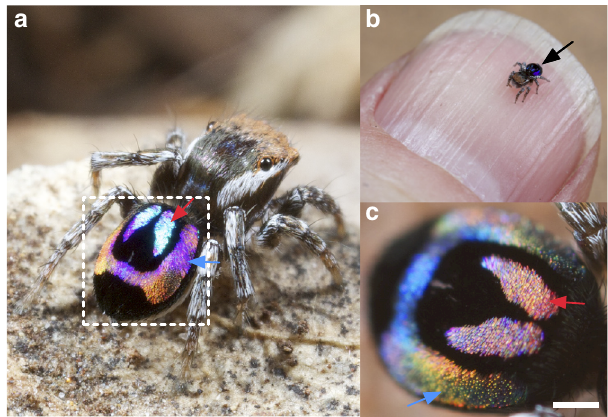
Fig. 1 A miniature peacock spider with rainbow-iridescence. a An adult male Maratus robinsoni . b A M. robinsoni resting on a human fi ngernail: the spider is only ~ 2.5 mm in size. The iridescent abdomen of the spider is indicated by the black arrow. c A zoom-in view (scale bar: 200 μ m) of the same spider abdomen as shown in the dashed square of a , but with different viewing angle. Note the colours of the iridescent patches almost change to their complementary colours between the two different views, from blue to red (red arrows), and from purple to yellow green (blue